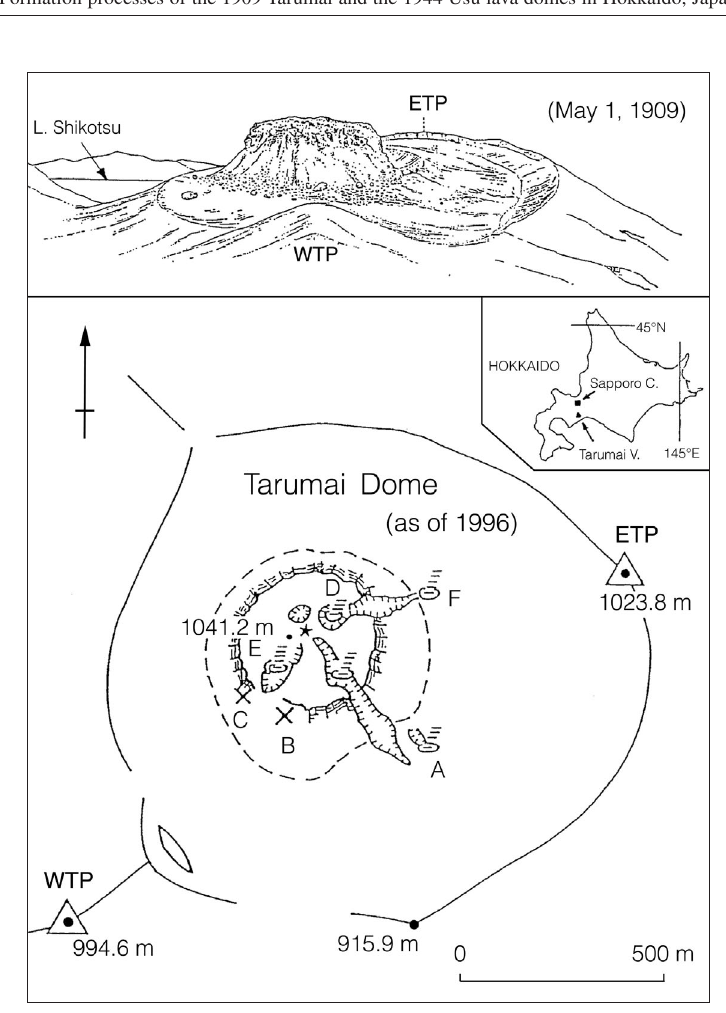
Fig. 1. A topographic sketch map of the 1909 Tarumai lava dome as of 1996. Letters A ∼ F denote fumaroles, and ETP and WTP triangulation and GPS points as of 2000. The scenery at the asterisk point on the dome is shown by photo 2. The top is a sketch of the dome viewed from WTP as of May 1, 1909 (Oinouye,